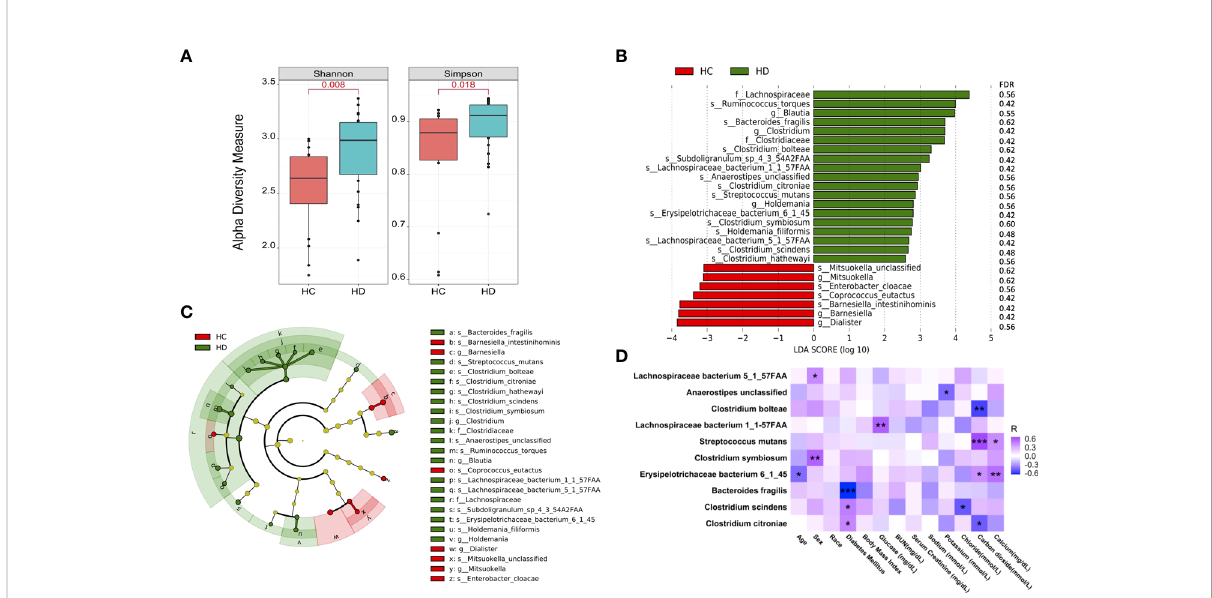
FIGURE 1 Microbial species are altered in HD patients. (A) Alpha-diversity of microbial community assessed by Shannon and Simpson index. (B) Signi fi cantly altered microbial species between HD patients and control subjects. (C) Cladogram of signi fi cantly altered microbes. (D) Correlations between the gut microbes with clinical data. * p -value < 0.05; ** p -value < 0.01; *** p -value < 0.001. BUN: blood urea